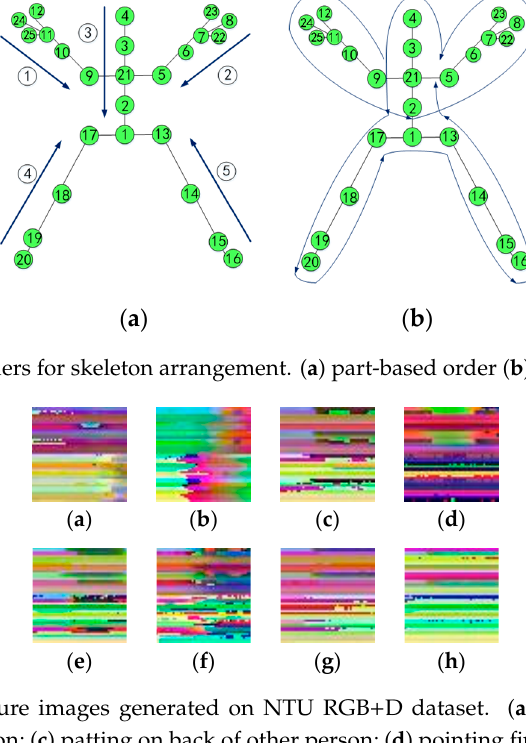
Figure 3. Sample feature images generated on NTU RGB+D dataset. ( a ) Kicking other person; ( b ) pushing other person; ( c ) patting on back of other person; ( d ) pointing finger at the other person; ( e ) hugging other person; ( f ) giving something to other person; ( g ) touching other person’s pocket; ( h ) handshaking.